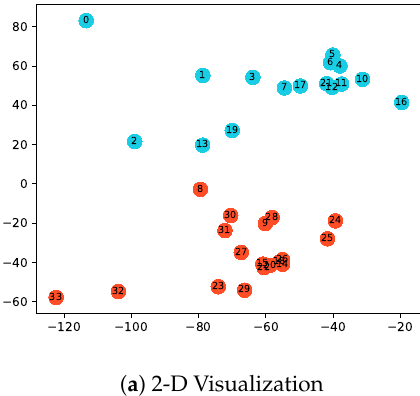
Figure 2. The illustration of the karate network and obtained node representations in 2-dimensional space with r = 0.5. Nodes in different clusters obtained by the k-means algorithm are marked in different